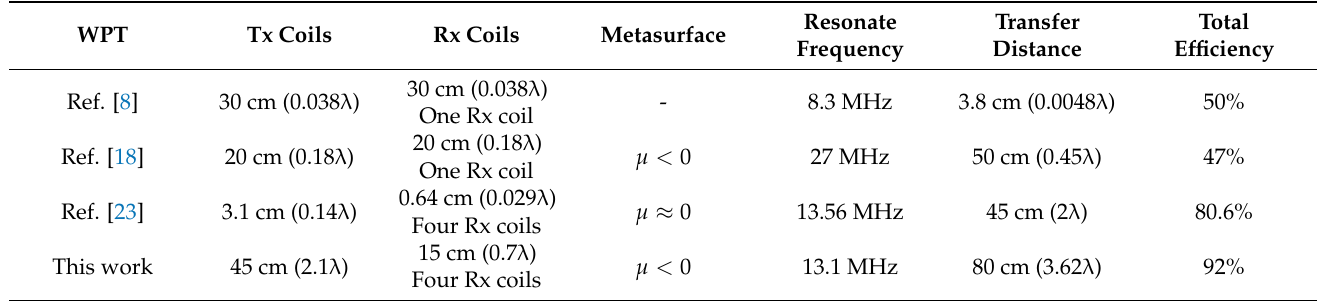
Table 4. The performance comparison between this work and previous